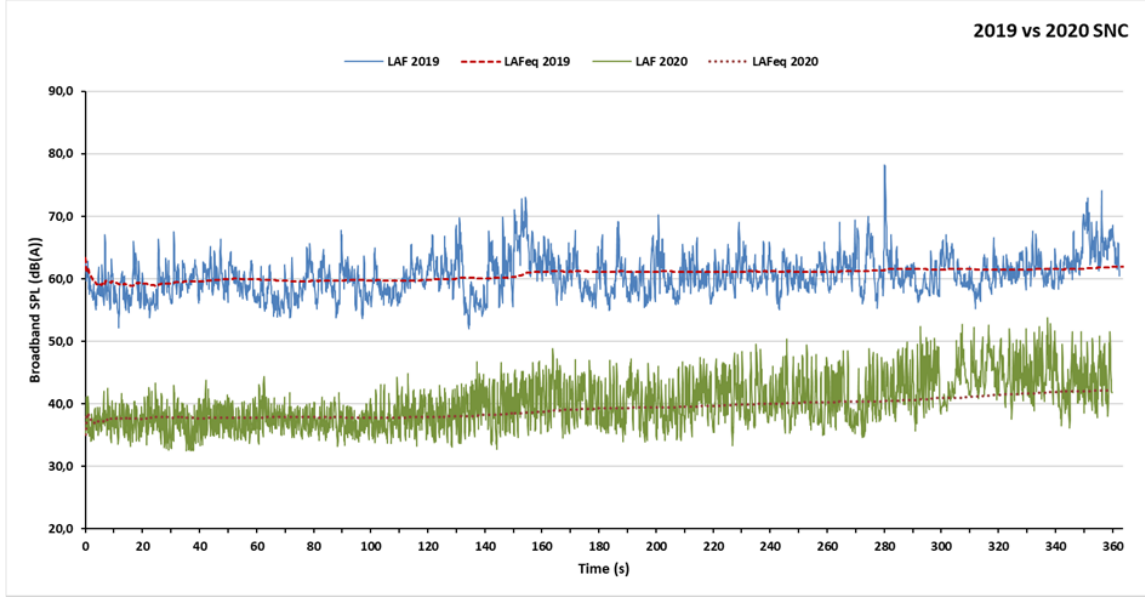
Figure 13: Broadband sound pressure levels in 2019 and during the lockdown in 2020 for the six minutes period recording together with the equivalent noise level at site no. 4